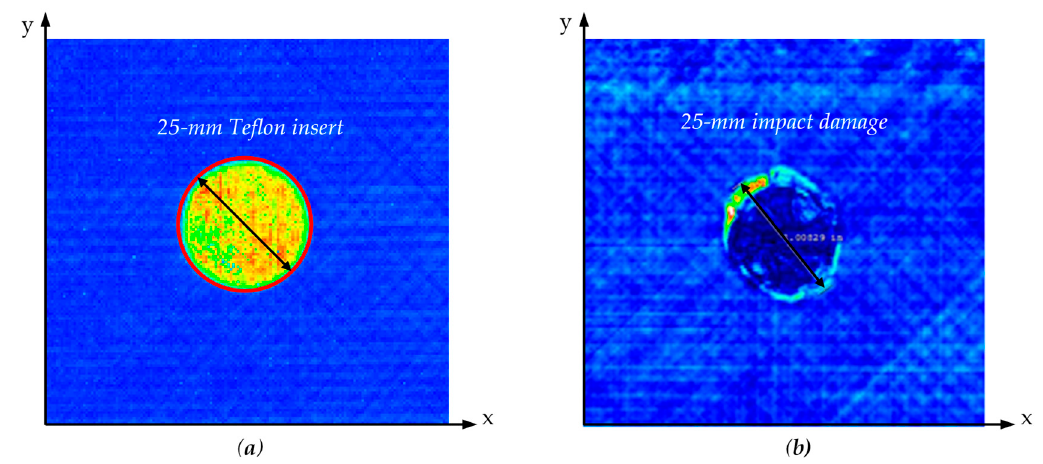
Figure 16. Ultrasonic C-scan results: ( a ) the delamination simulated by the Teflon insert; ( b ) impact damage.